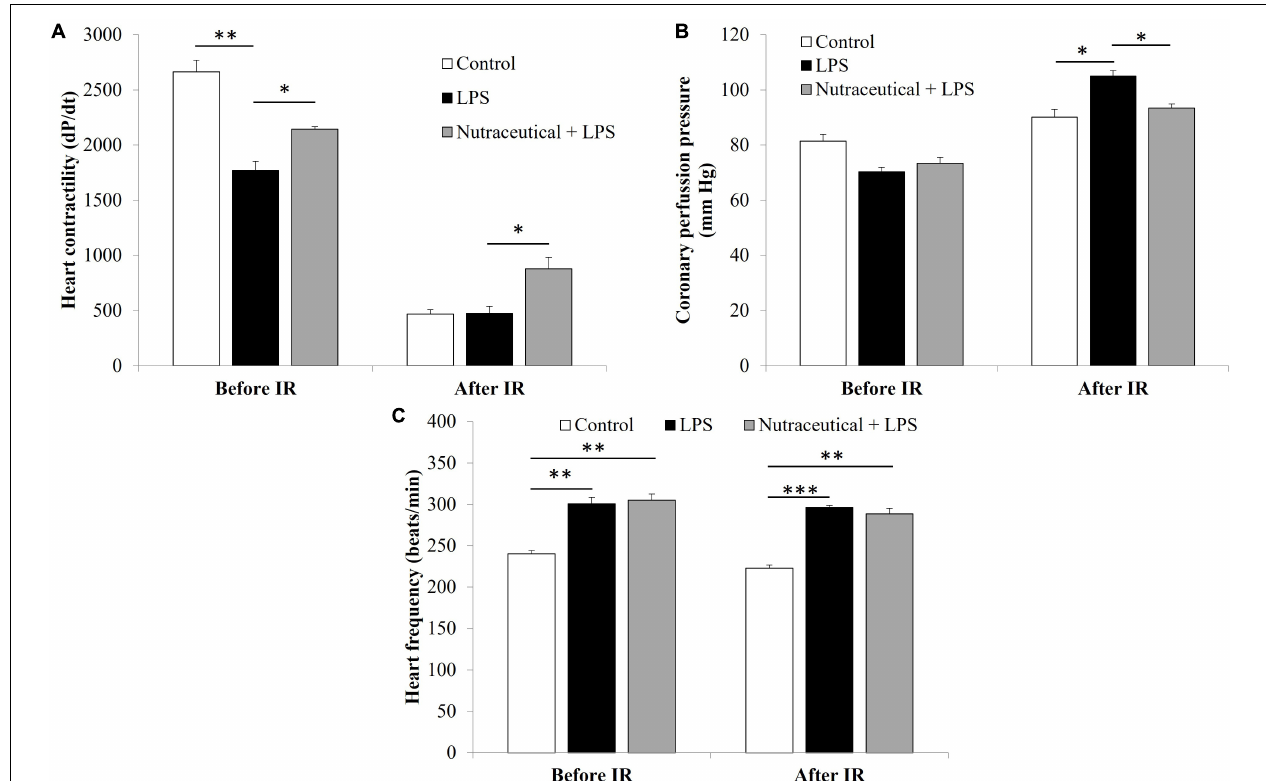
FIGURE 1 | Heart contractility (A) , coronary perfusion pressure (B) and heart frequency before and after ischemia reperfusion (IR) of rats treated with vehicle, LPS or LPS + Nutraceutical. Values are represented as mean ± SEM. ∗ p < 0.05; ∗∗ p < 0.01; ∗∗∗ p <